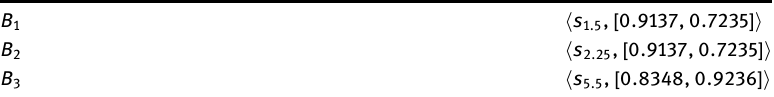
Table 11: Degree of